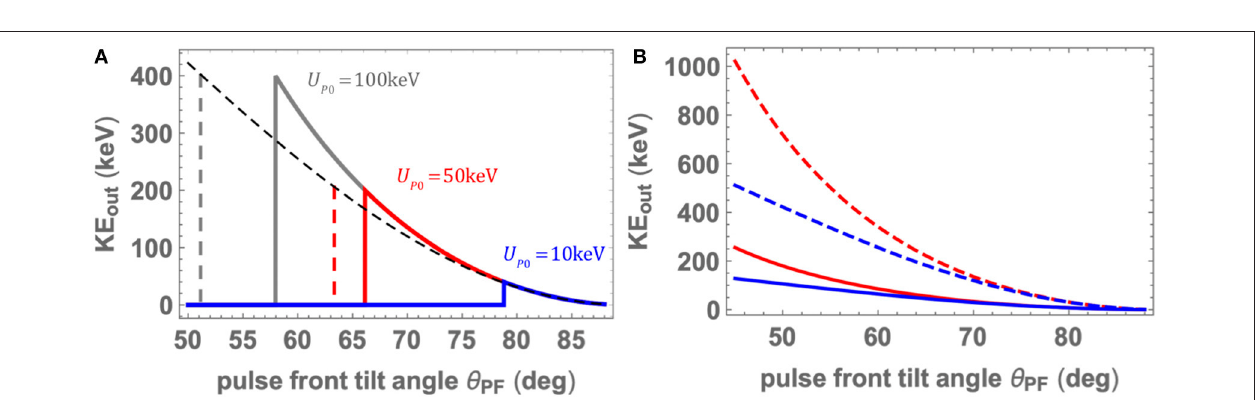
FIGURE 3 | (A) Output kinetic energy as a function of the PFT angle for several fixed values of peak ponderomotive potential. The dashed curve shows the non-relativistic capture threshold. The vertical dashed lines represent the capture threshold angle in the non-relativistic approximation. (B) Threshold ponderomotive potential (solid) and output kinetic energy (dashed) as a function of PFT angle. The color of the curves correspond to the non-relativistic (blue) and relativistic (red)